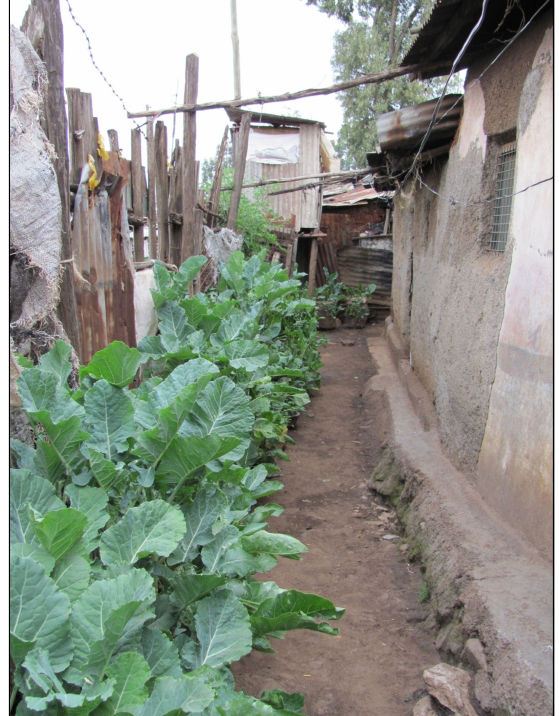
Figure 3. Finding Adequate Space to Place the Sack Gardens is One of the Major Challenges Faced by Farmers in Kibera This row of sacks is shared by four different households and occupies the front yard (alley) shared by these houses.